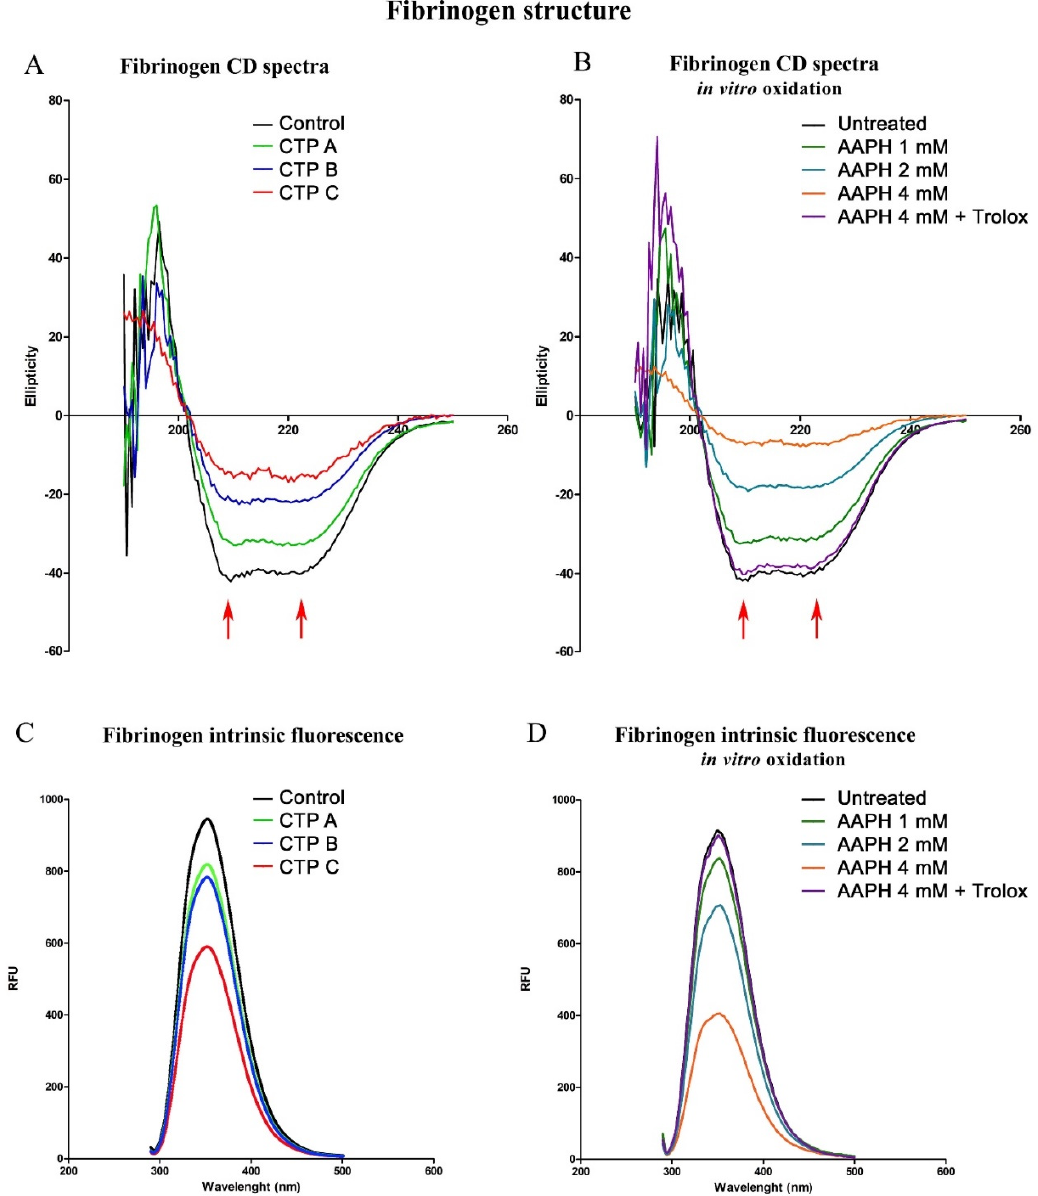
Figure 4. Fibrinogen structure. ( A ) Representative far-UV circular dichroism spectra of fibrinogen purified from patients with liver cirrhosis at different disease severity and controls. The two negative peaks observed in controls at 208 and 222 nm (arrows) are typical of protein α -helix structure.